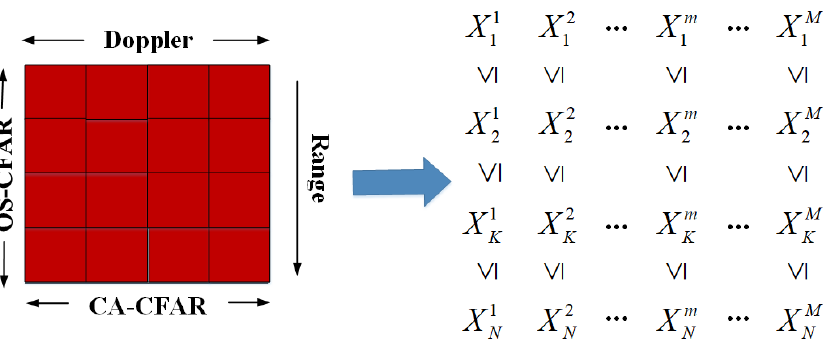
Figure 4. OSCA-CFAR detection.